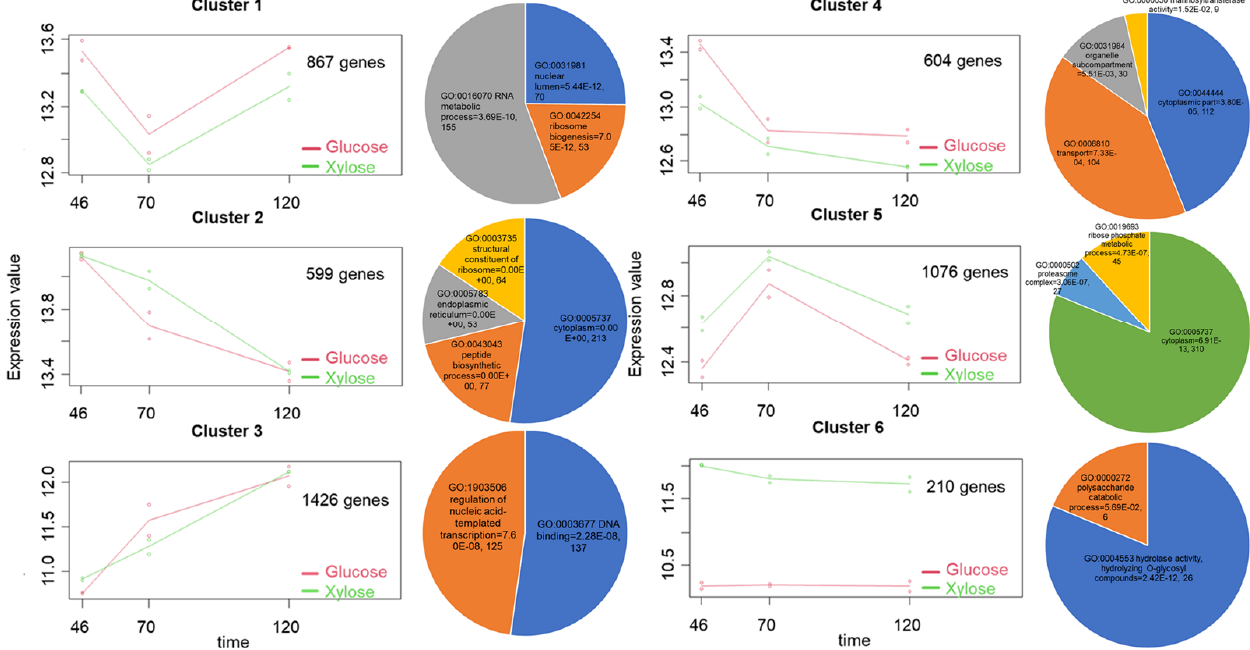
Figure 7. Trajectories and GO functional enrichment of expressed gene clusters in Saitozyma podzolica DSM 27192 cultivated glucose and xylose. Profiles of six clusters over three time points (46, 70 and 120 h) were generated using maSigPro and gene ontology-based functional association was plotted in the adjacent pie charts. In the line graphs, the dots per time point represent the mean expression values per biological replicate. Gene ontology (GO), false discovery rate values and number of genes associated with each GO are shown in the pie charts.